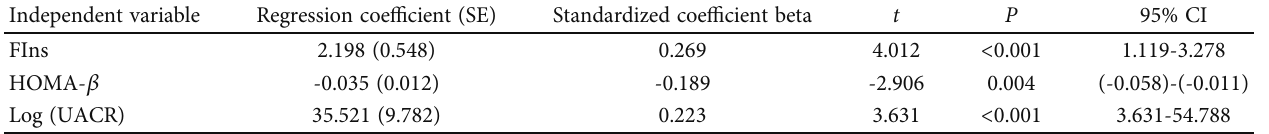
Table 4: Stepwise multiple linear regression analysis with EDA as the dependent